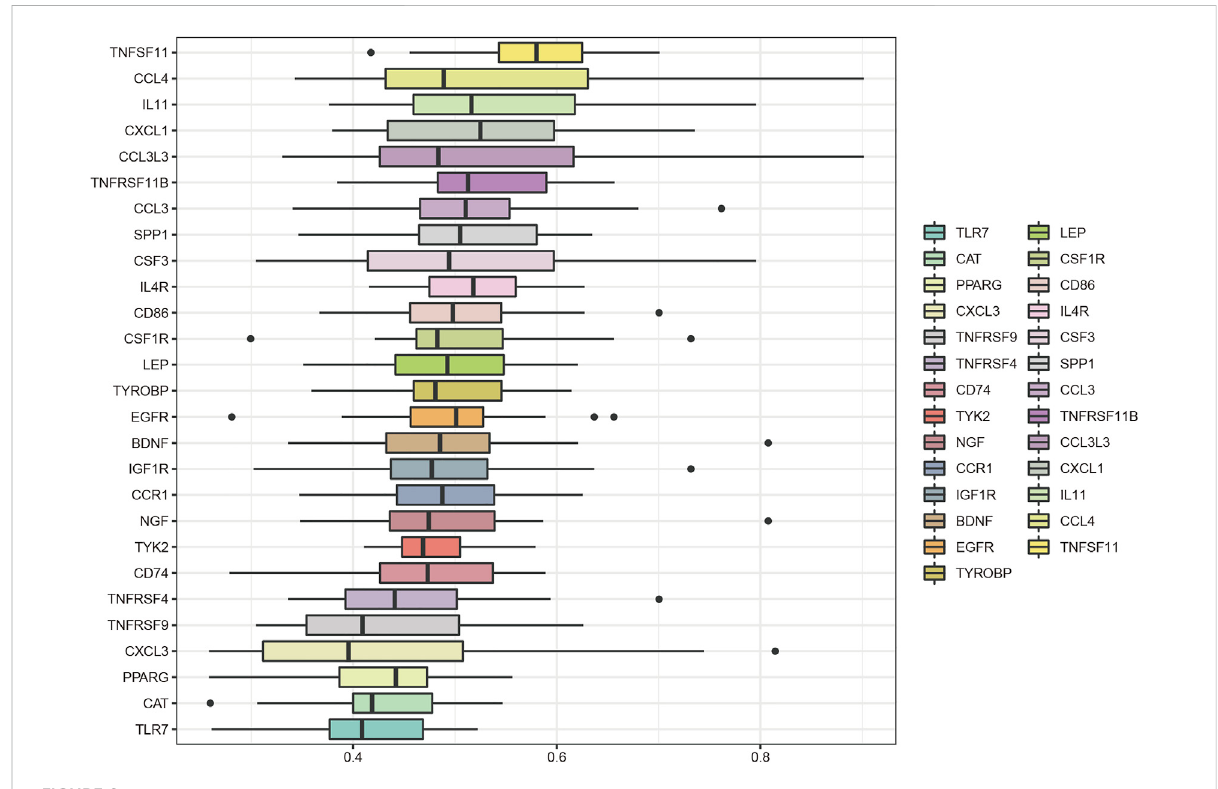
FIGURE 9 Friends analysis. The box plot shows the functional similarity of the DEGs associated with LFH immunity with other genes. TNFSF11 showed the strongest correlation with other